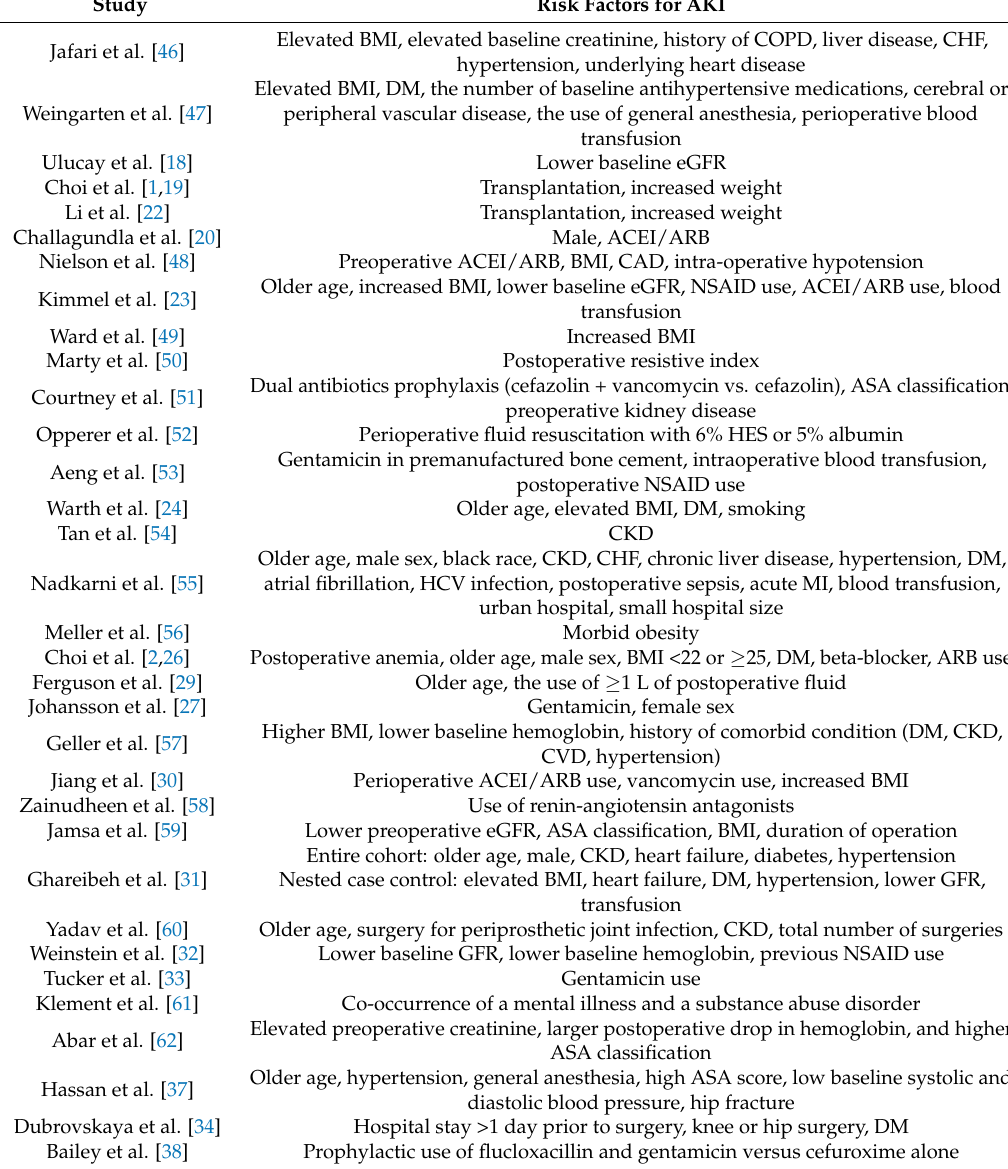
Table 2. Reported Risk Factors for AKI in patients undergoing THA